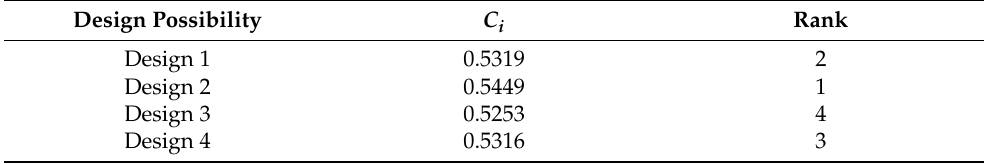
Table 10. Ranking of the design possibility (managers).